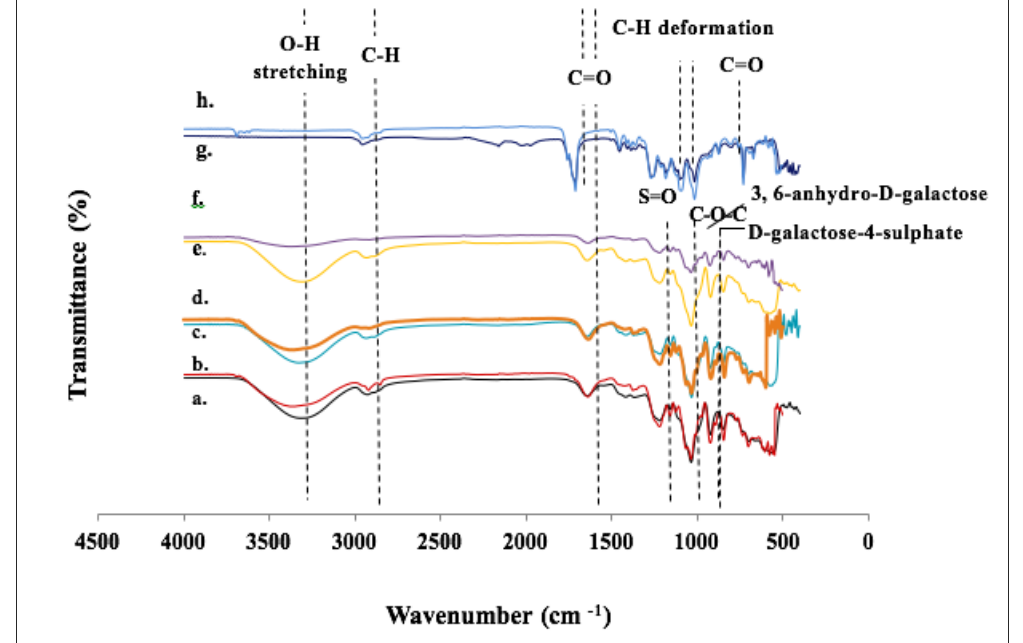
Figure 3. Fourier transform infrared (FT-IR) spectra of seaweed-based films filled with fillers and conventional mulch film before and after soil